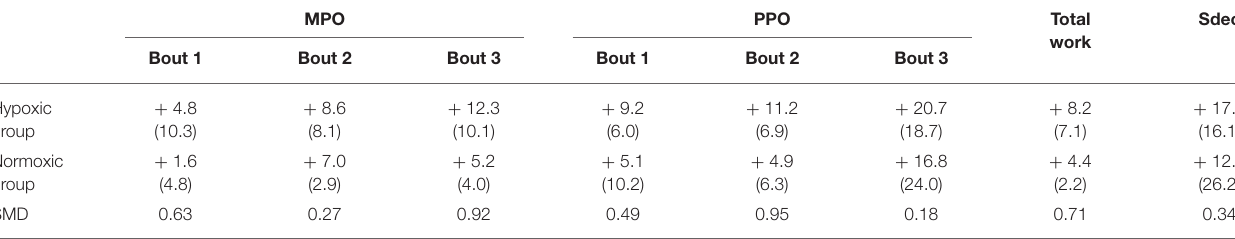
TABLE 1 | Percent change for performance variables between pre- and post-tests. MPO PPO